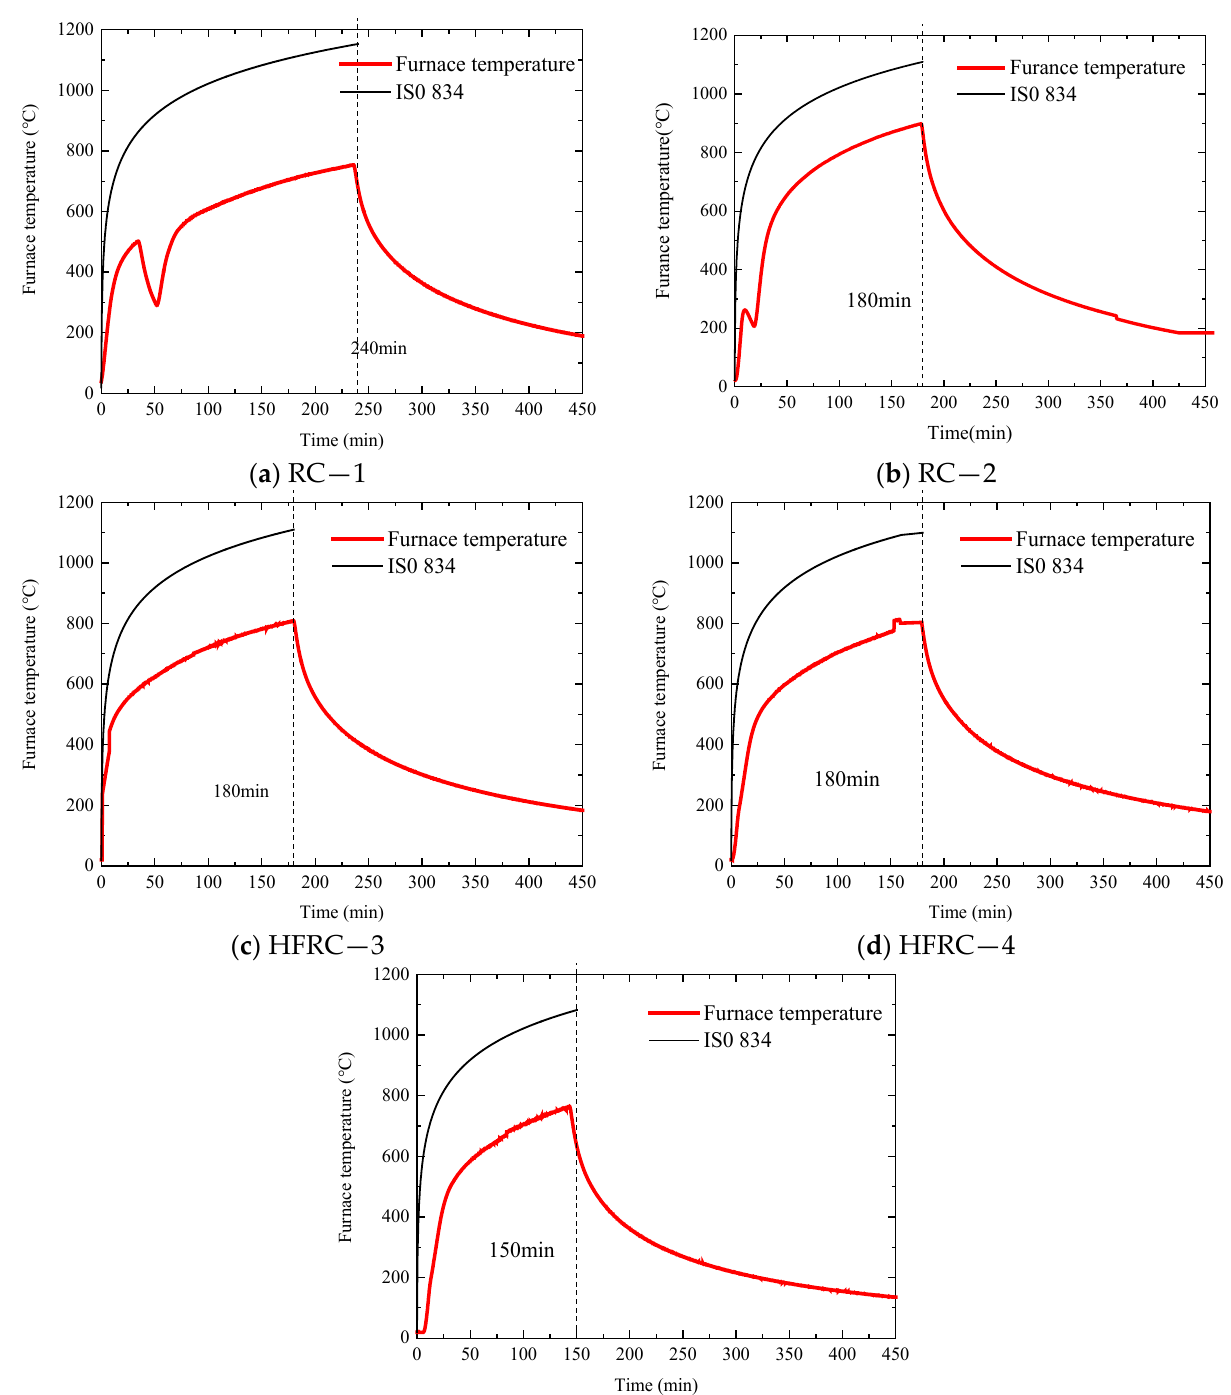
Figure 6. Furnace temperature–time curves: ( a ) RC − 1; ( b ) RC − 2; ( c ) HFRC − 3; ( d ) HFRC − 4; and ( e ) HFRC − 5.